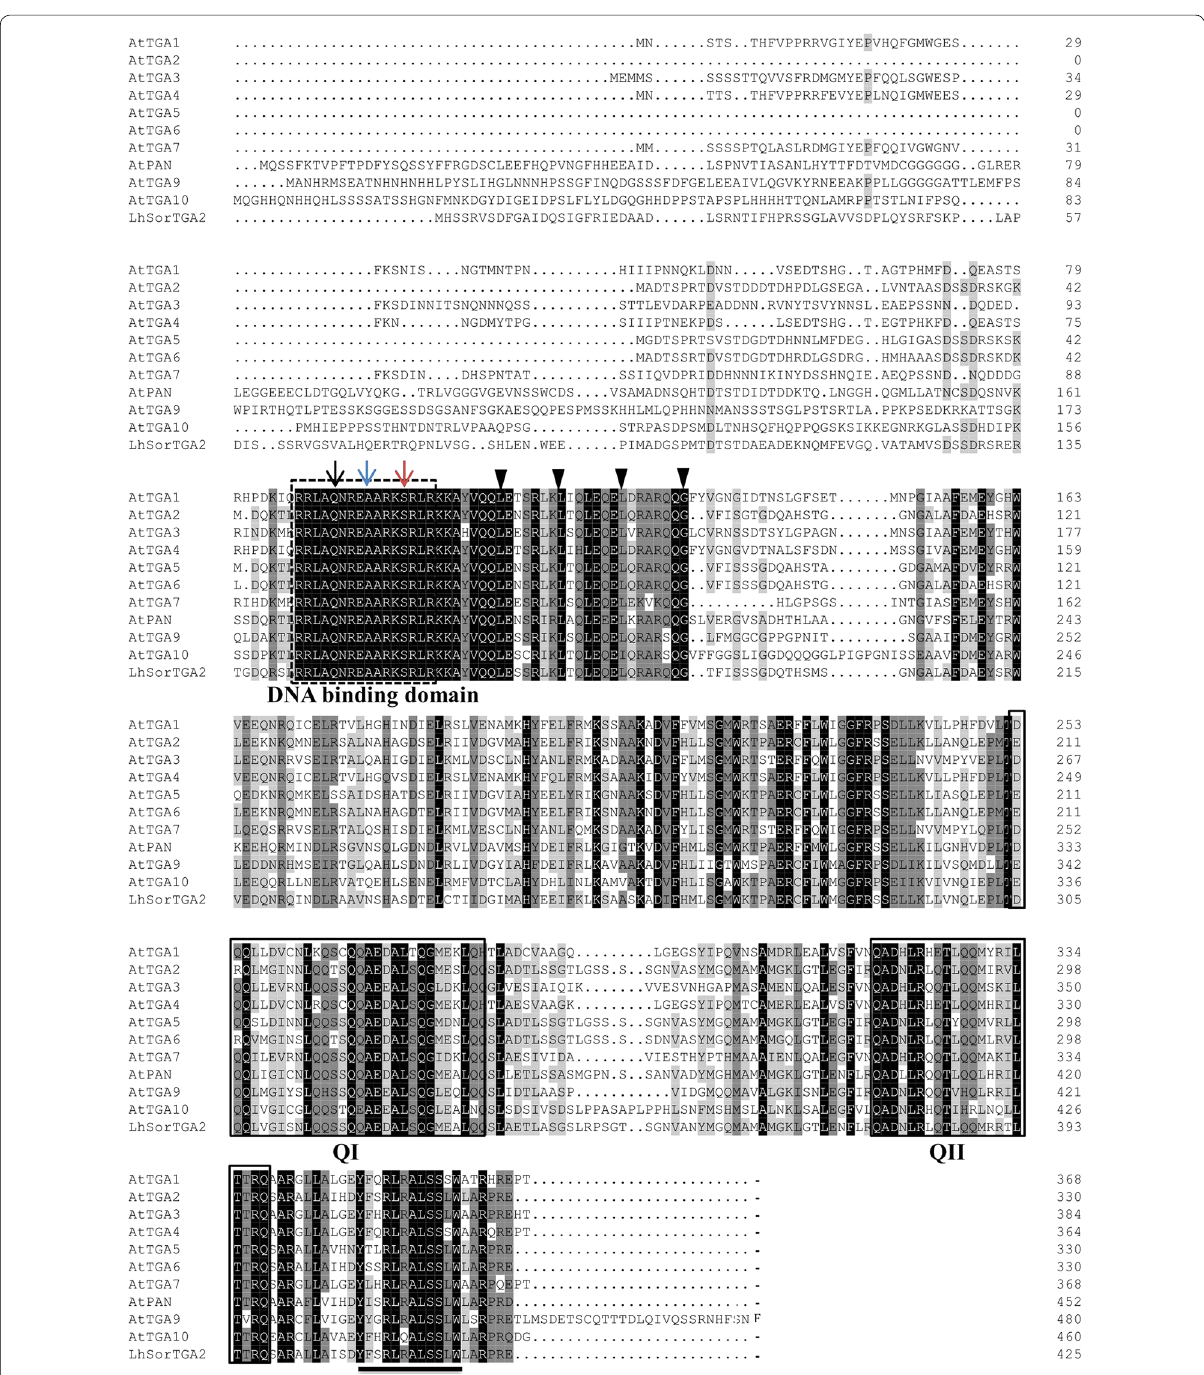
Fig. 1 Sequence alignment of LhSorTGA2 with proteins of the TGA family in Arabidopsis . Sequences were aligned using Clustal W. Identical residues are shaded in black, highly similar residues are shaded in dark gray, and similar residues are shaded in gray. The DNA binding domain (DBD) is indicated by a dashed line box. The conserved glutamine residues (black arrow), alanine residues (blue arrow) and serine residues (red arrow), are indicated by arrows. Three leucine residues and one glycine residue for the four heptad repeats in leucine zipper are highlighted by triangles. Two glutamine rich acid domains (QI and QII) that mediate transcription activation are highlighted by solid line boxes. The signature sequence for group D bZIP transcription factors, Yx 2 RL[RQ]ALSS[LS]W, is underlined. The accession numbers of all the TGA proteins used for sequence alignment are listed in Additional file 2: Table